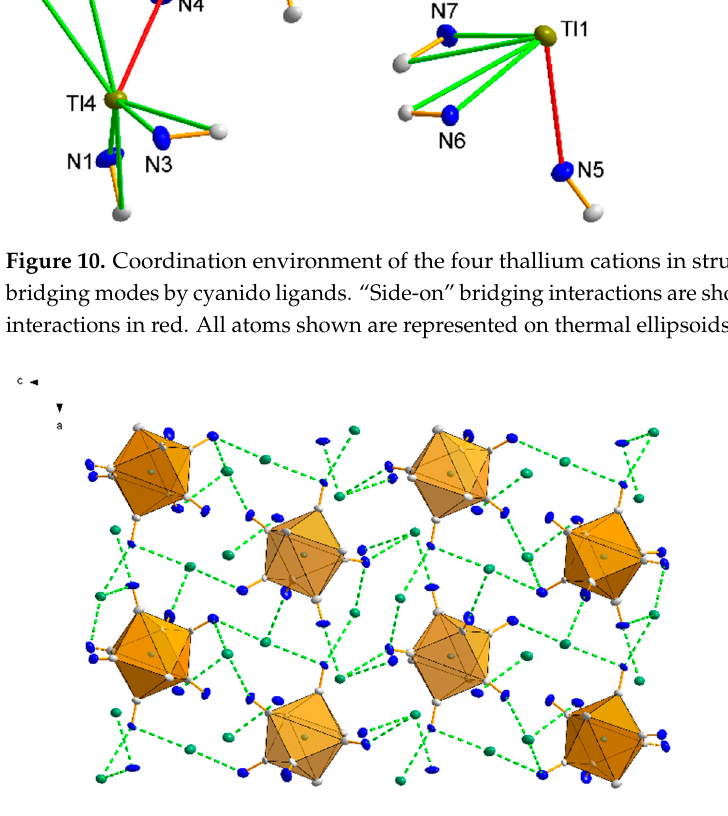
Figure 11. The spatial arrangement of molecules seen in the [010] direction in structure 5 . The green dashed lines indicate the interactions of thallium cations with cyanido nitrogen atoms.